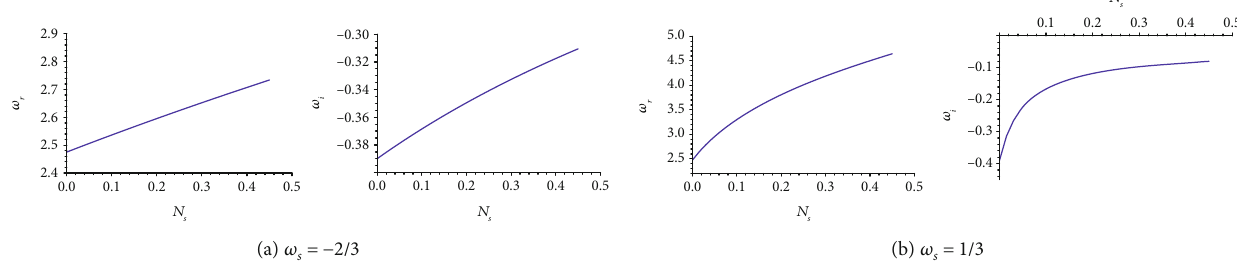
around the AdS s